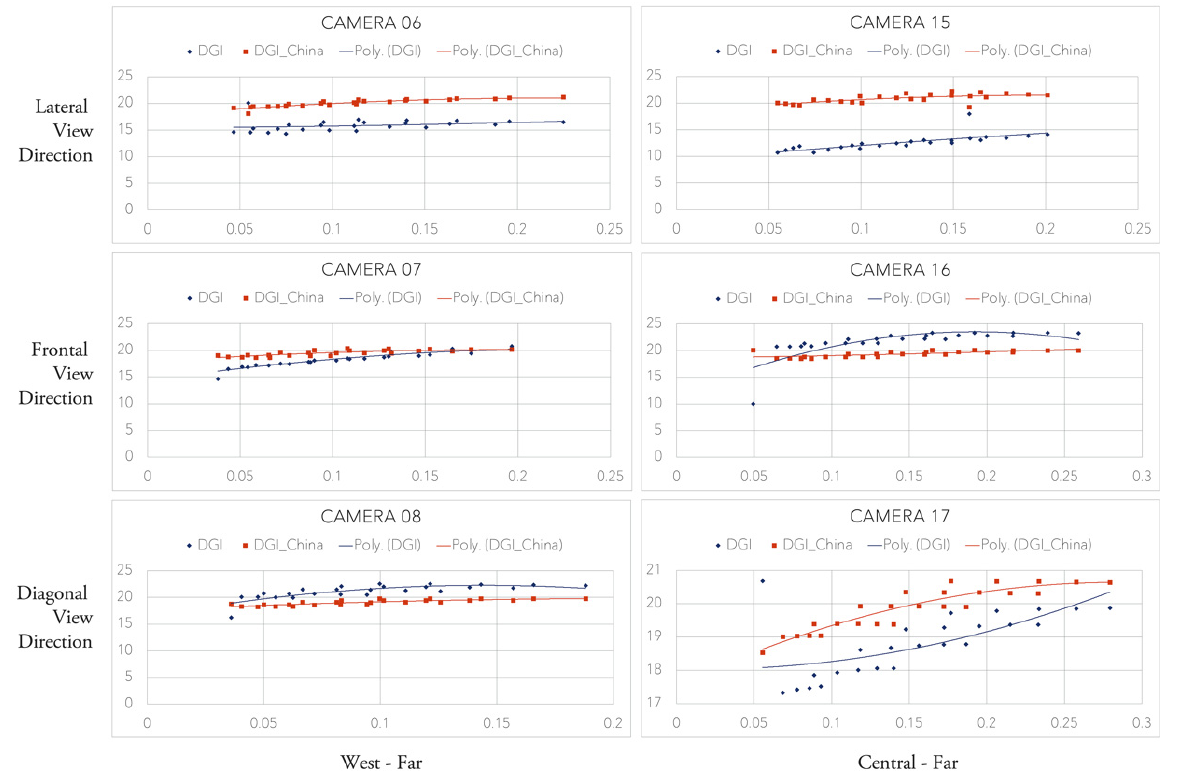
Figure 10. Comparative study on camera viewing location in the back of the room with solid angles ( X -axis) against DGI and DGI China evaluation ( Y -axis).